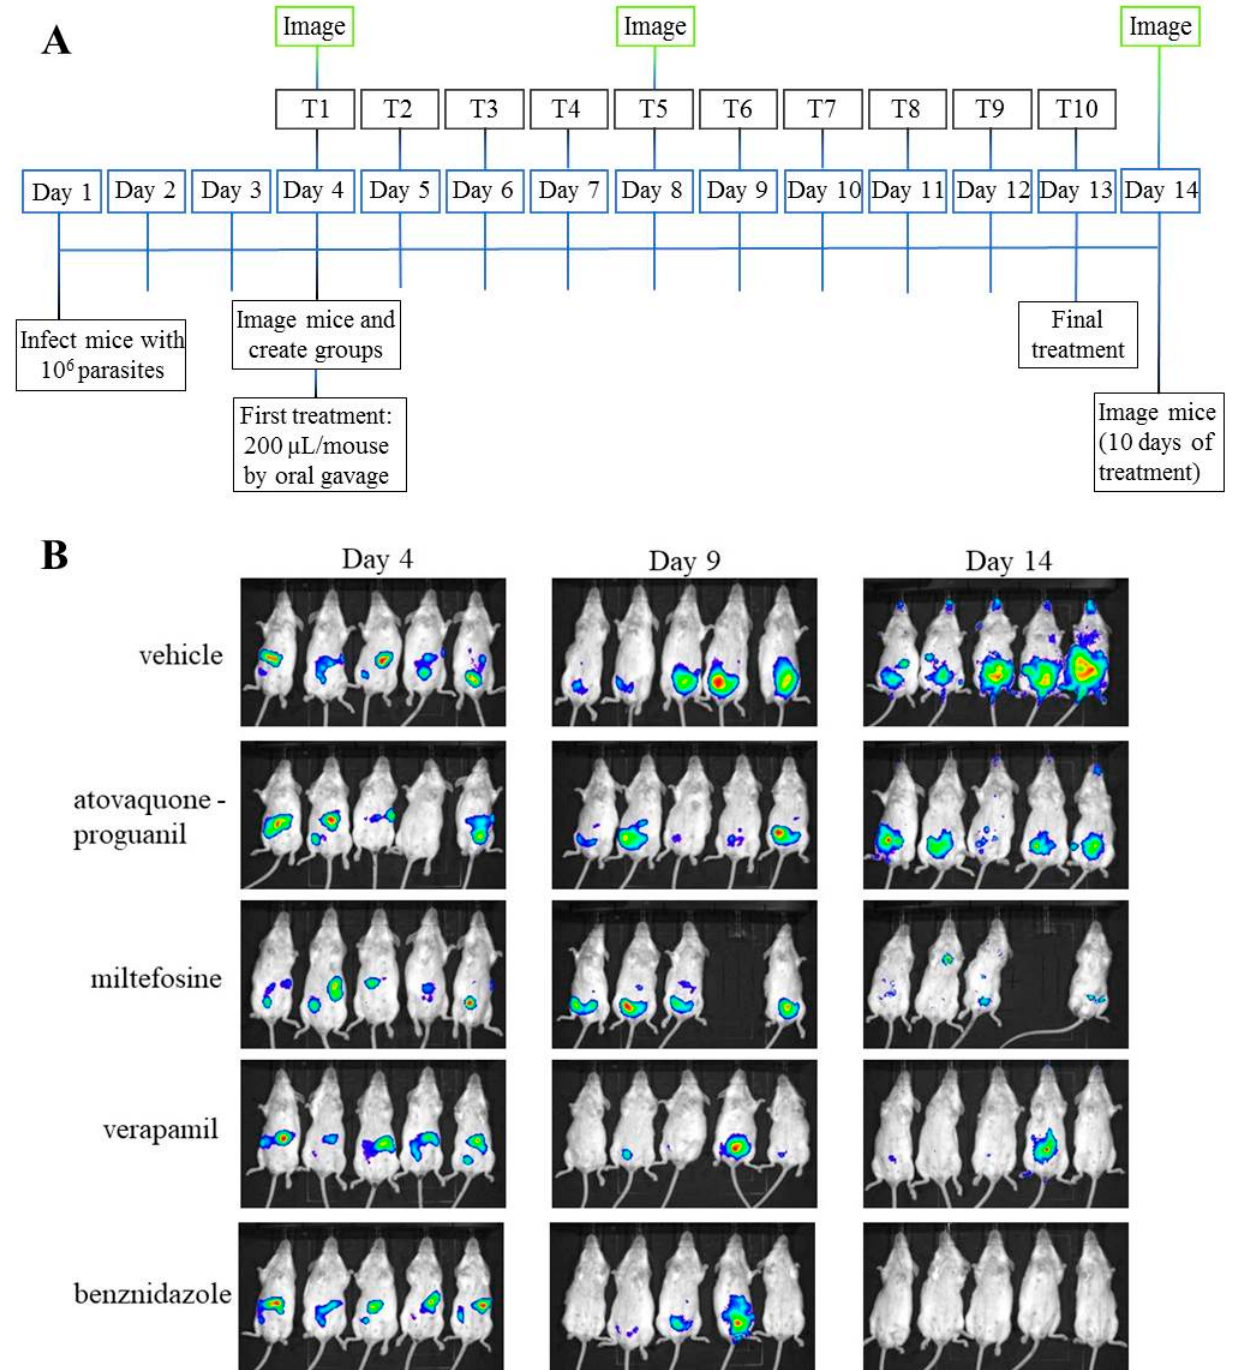
Figure 7. Scheme of the in vivo assessment of the three selected drugs against T. cruzi in an acute infection model ( A ) Timeline of events in the acute in vivo study (T1 to T10 depict the days of treatment). ( B ) Images of mice after 0, 5 and 10 days of treatment.